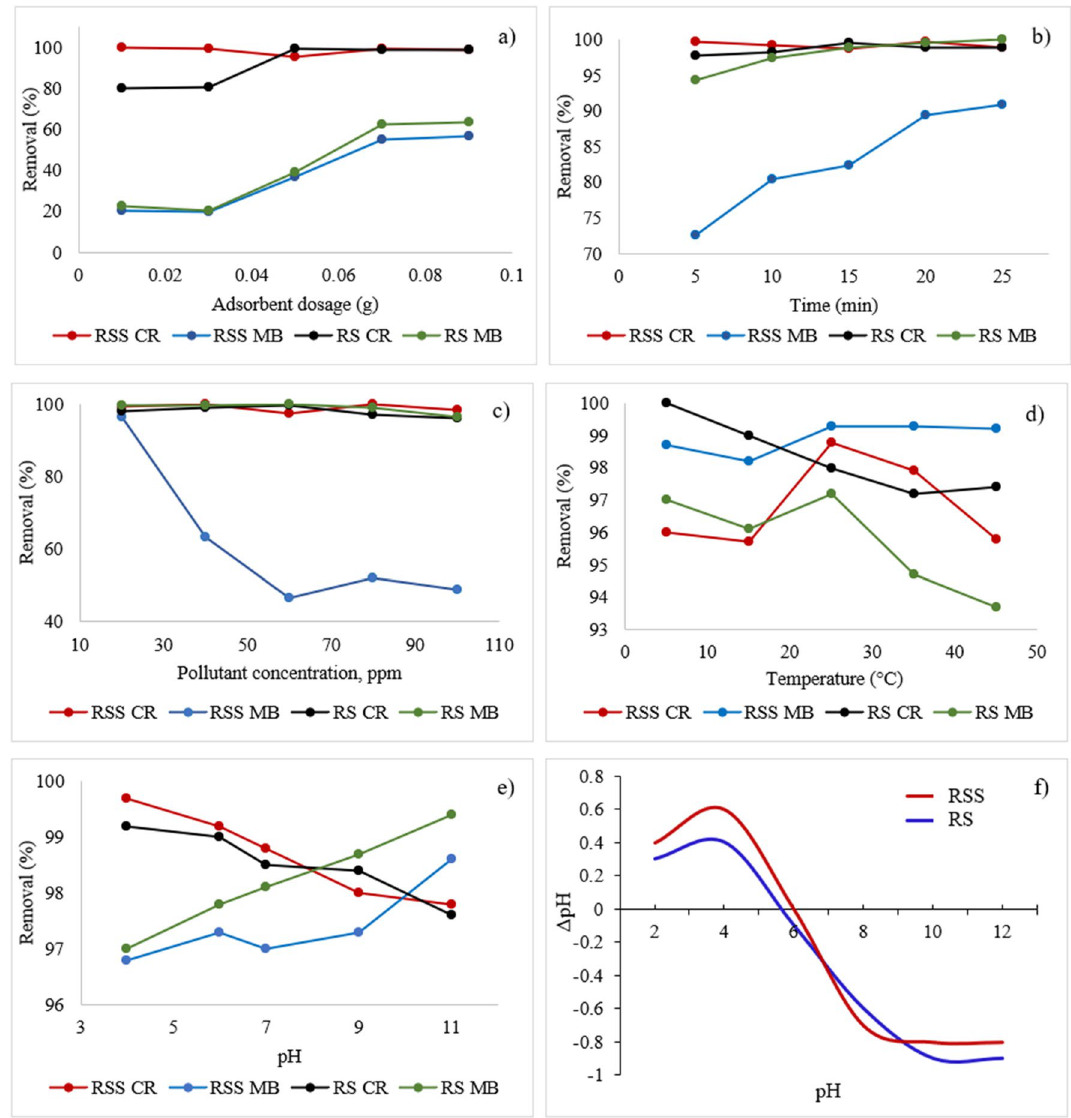
Figure 8. Effect of ( a ) adsorbent dose, ( b ) contact time, ( c ) pollutant concentration, ( d ) temperature, ( e ) pH on the adsorption of dyes by the PAC, and ( f ) The pHpzc values for RS and